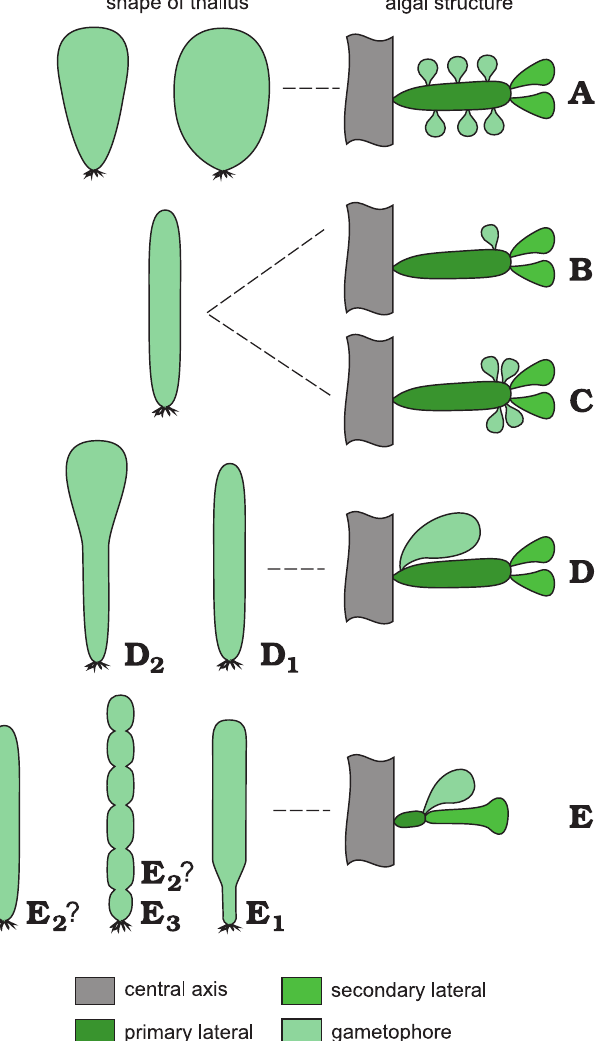
Fig. 4. A comparison of selected dasycladalean genera compared. A .